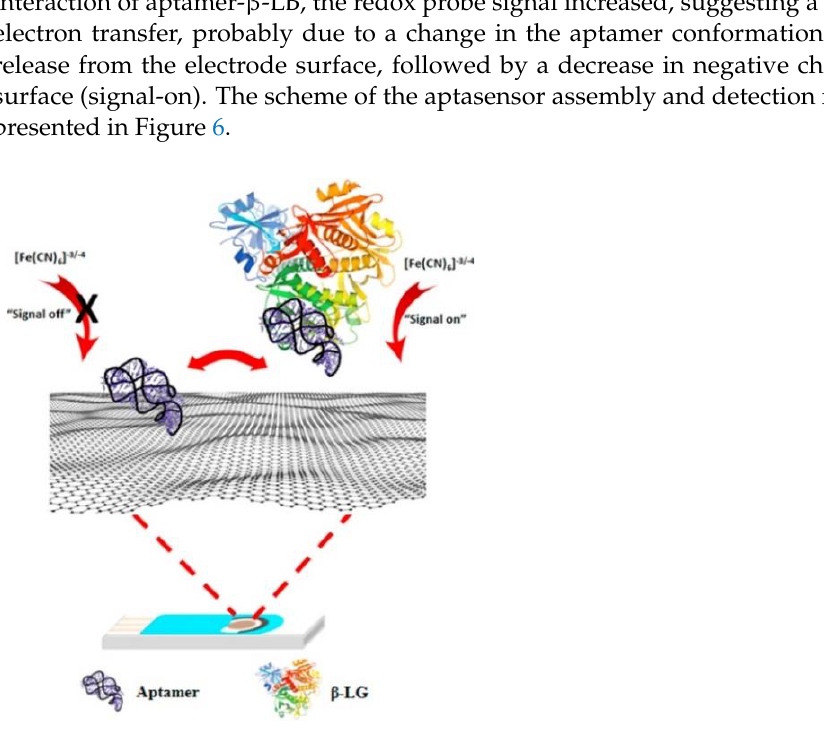
Figure 6. β -LB detection scheme based on aptamer-functionalized graphene screen-printed electrode. Reprinted with permission from [111]. Copyright 2017, Elsevier.